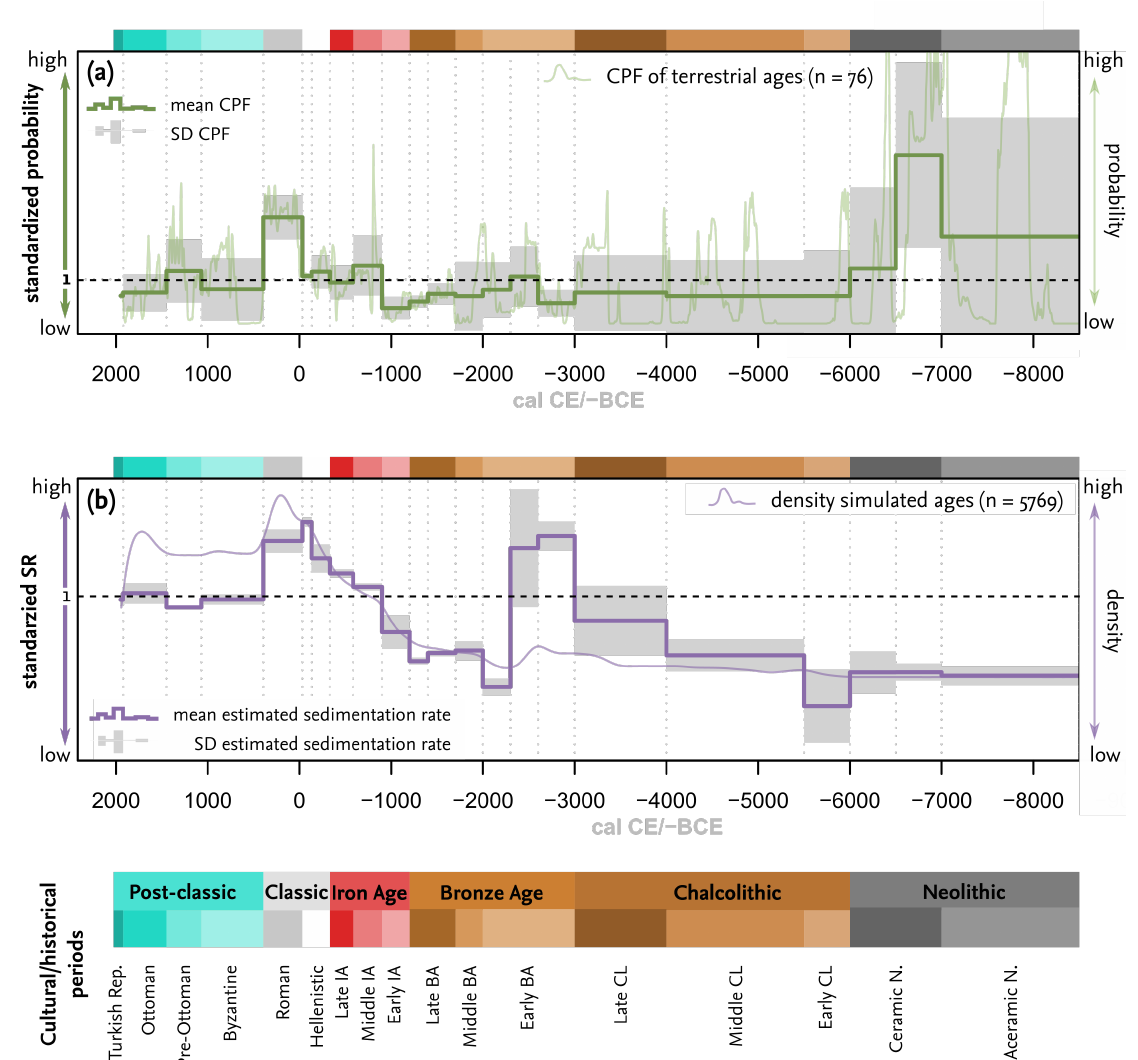
Figure 6. ( a ) Cumulative probability function (CPF) and ( b ) average sedimentation rate of sediment sequences obtained from the western lower Bakırçay plain. Both data are normalized based on the null model and are averaged over archaeological periods (bold lines; see Table A1); also the non-normalized data are displayed, as shown in Figure 3. Grey backgrounds indicate the variability within the archaeological period. The dashed lines indicated no difference between the observed data and the null model. SD = standard deviation, SR = sedimentation rate, N = Neolithic, CL = Chalcolithic, BA = Bronze Age, IA = Iron